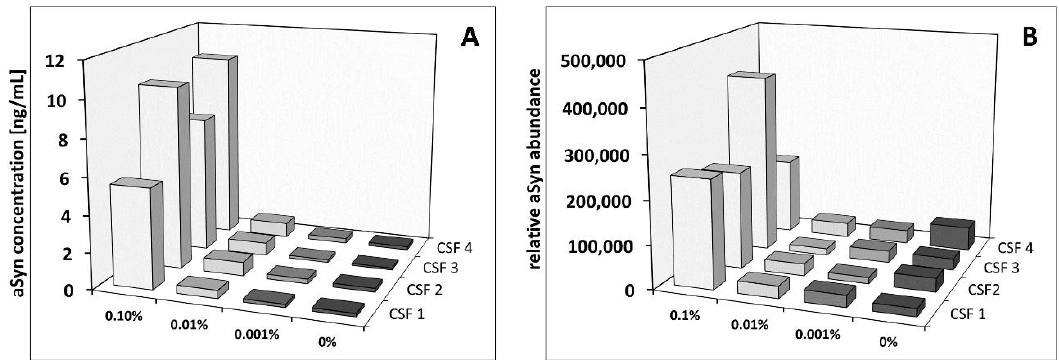
Figure 7. Influence of blood contamination on the quantification of aSyn using ELISA and label-free-based MS using artificially blood-contaminated CSF. Comparative quantification of aSyn in non- and artificially blood-contaminated CSF samples in the range of 0.001% to 0.1% from four different individuals (CSF 1 to CSF 4) was performed with ELISA ( A ) and MS-based analysis ( B ). Shown are in (A) the aSyn concentrations in ng / mL and in (B) the relative abundance obtained with the data analysis utilizing the MS software Progenesis QI.